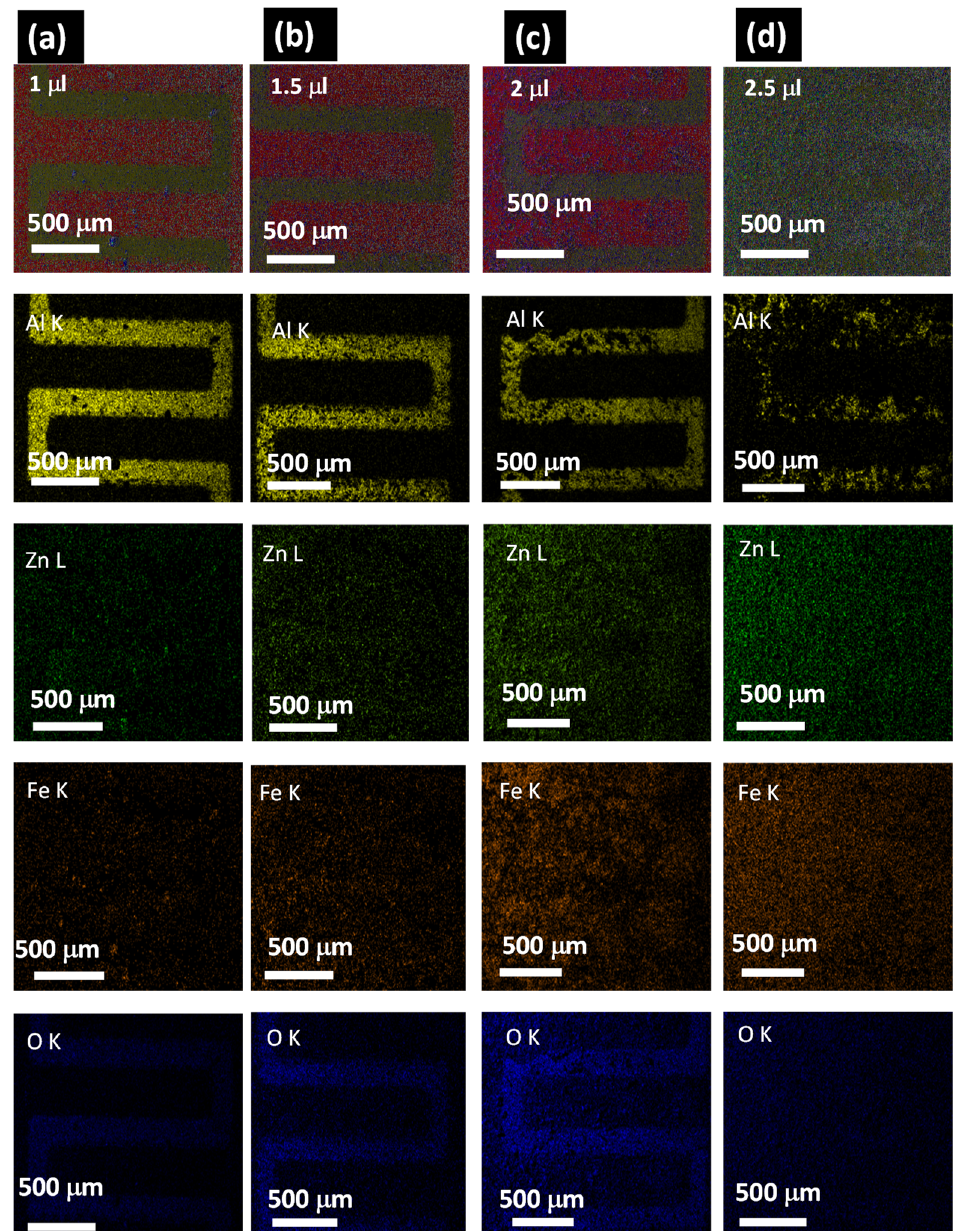
Figure 5. ( a – d ) EDS elemental mapping (Al, Zn, Fe and O) on the top view of ZnFe 2 O 4 NP sensing films deposited at volumes of 1.0, 1.5, 2.0, and 2.5 µL,